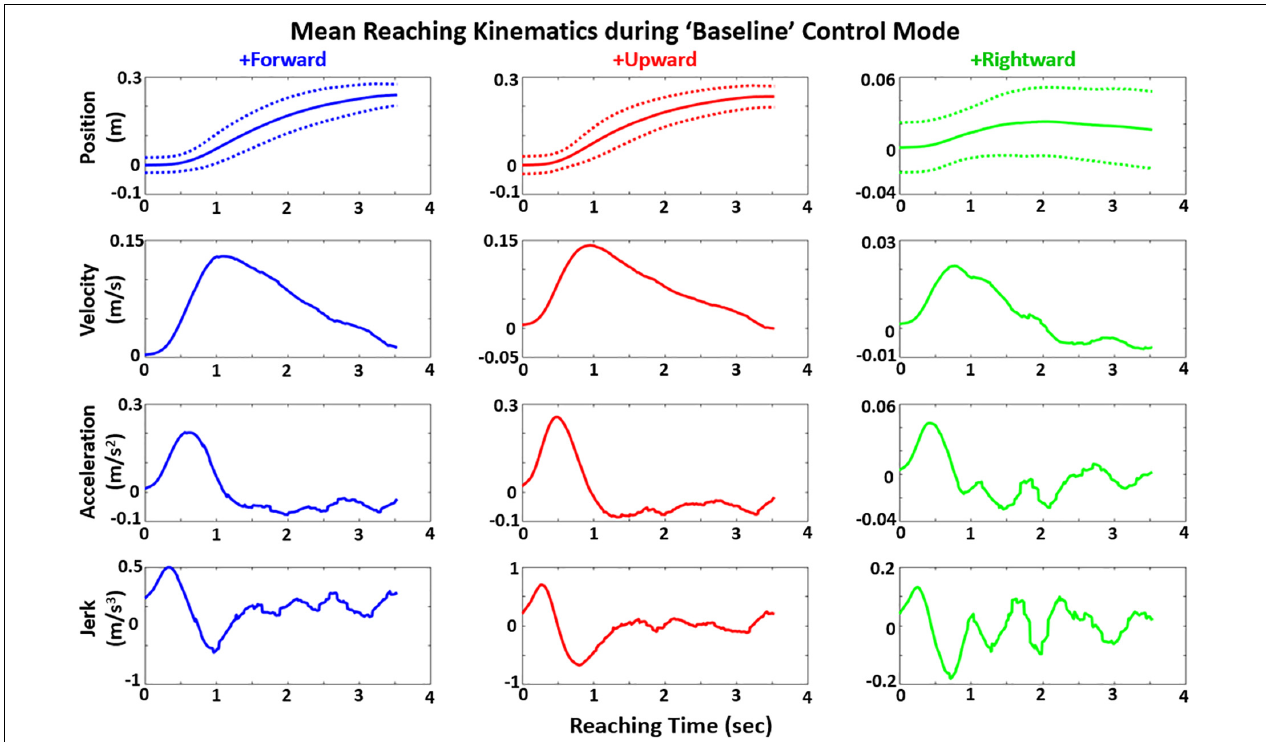
FIGURE 8 | Mean position (with standard deviation dotted bands), velocity, acceleration, and jerk profiles for reaching hand shown in each movement direction for “Baseline” control mode across all subjects. For these mean trajectory plots, the trajectory of each subject was projected to fit across the average reach-to-contact time of 3.49 s for all subjects prior to trajectory averaging.